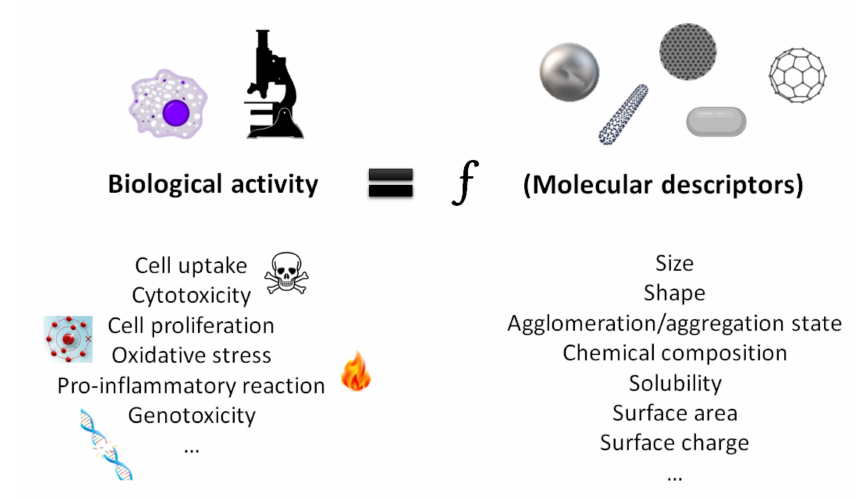
Figure 2. Basic principle of QSAR models for